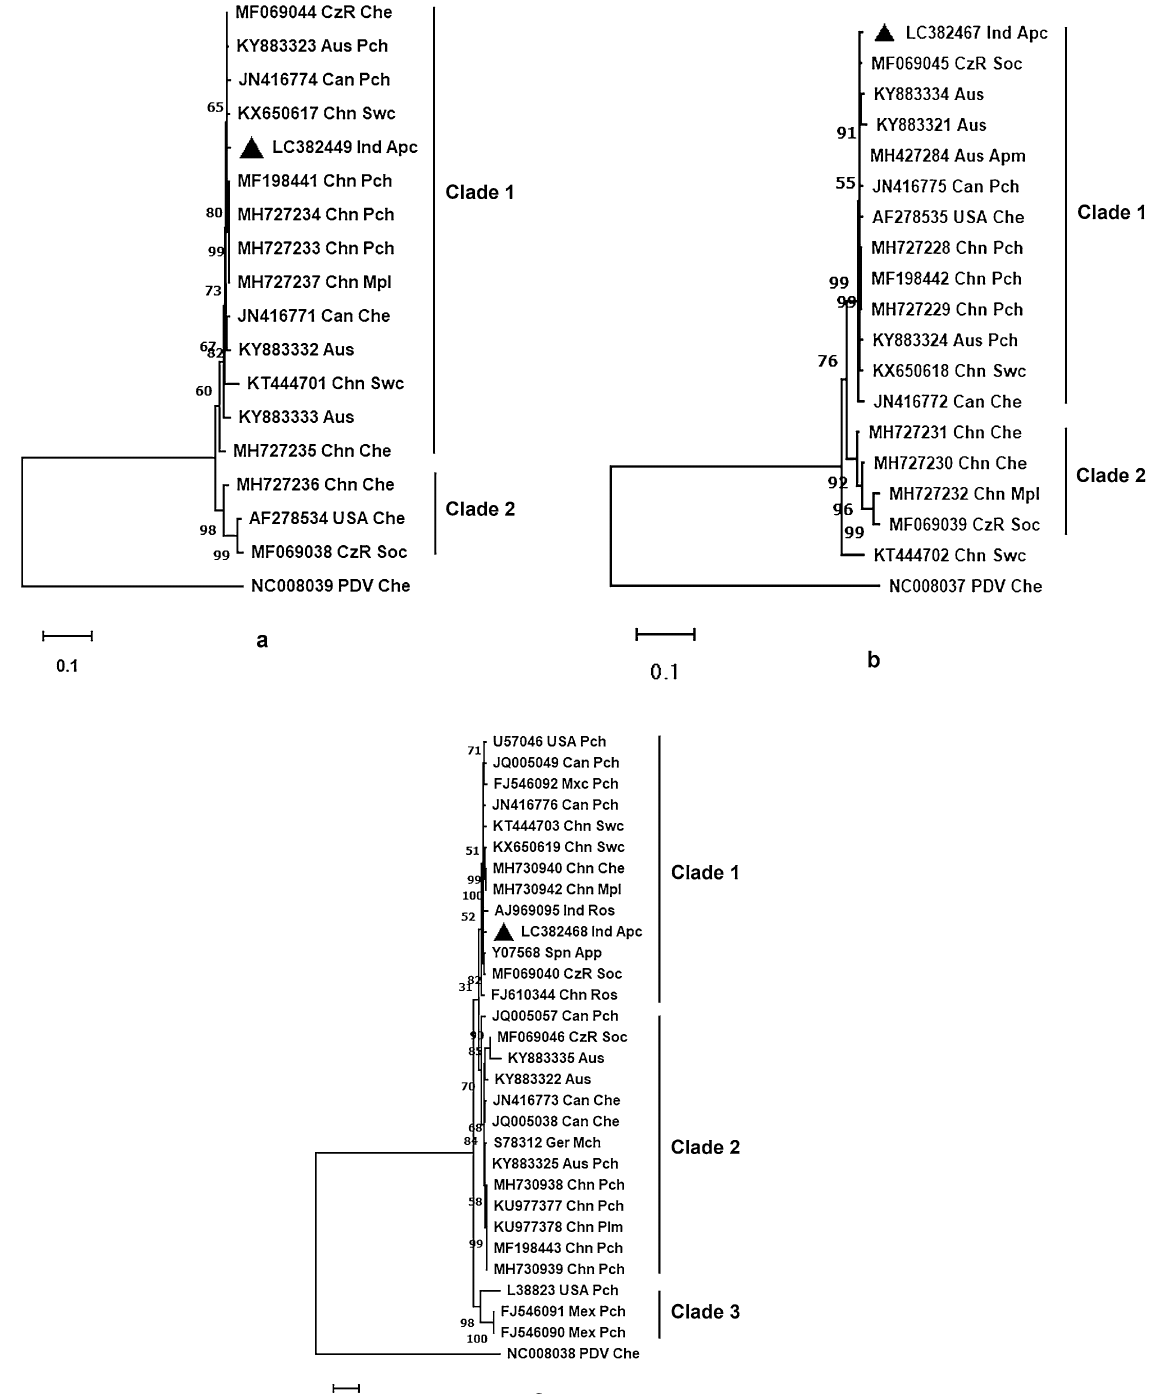
Figure 7. Phylogenetic trees ( a , b , c ) constructed with the Neighbor-Joining methodusing the full nucleotide sequences of RNA 1, 2 and 3 from prunus necrotic ringspot virus (PNRSV) isolates and prune dwarf virus (PDV) as the outgroup. In total, 17 (RNA1), 18 (RNA2) and 28 (RNA3) complete putative sequences were shortlisted for this study. MEGA11 were used to build pairwise, multiple sequence alignments, and visualize the tree. The accession number, country of origin, and natural host of each isolate are all listed on the terminal location of the branch. The black triangle represents the Indian isolate under